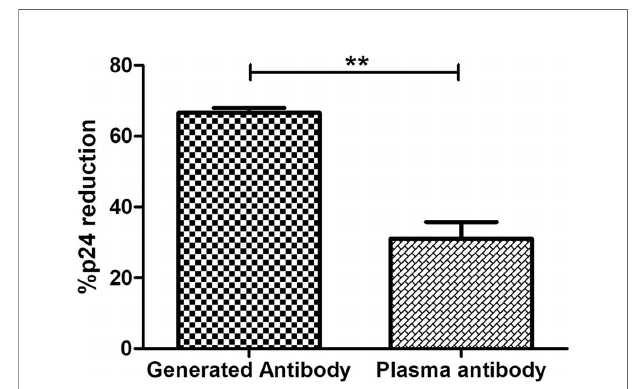
FIGURE 6 | Comparison of potency to reduce latent reservoirs of generated antibodies and paired plasma antibodies. The bar diagram represents the comparative analysis of reduction in percent p24-expressing resting memory CD4+ T cells in the presence of antibodies generated from R-ADCC ( n = 5) LTNPs and puri fi ed plasma antibodies of the same LTNPs ( n = 5) (paired t -test, p = 0.0016). The ** represents P ≤